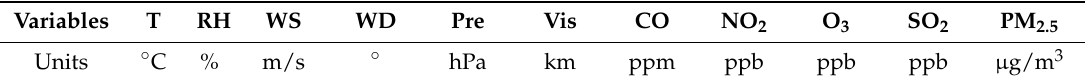
Table 1. Units of variables measured at